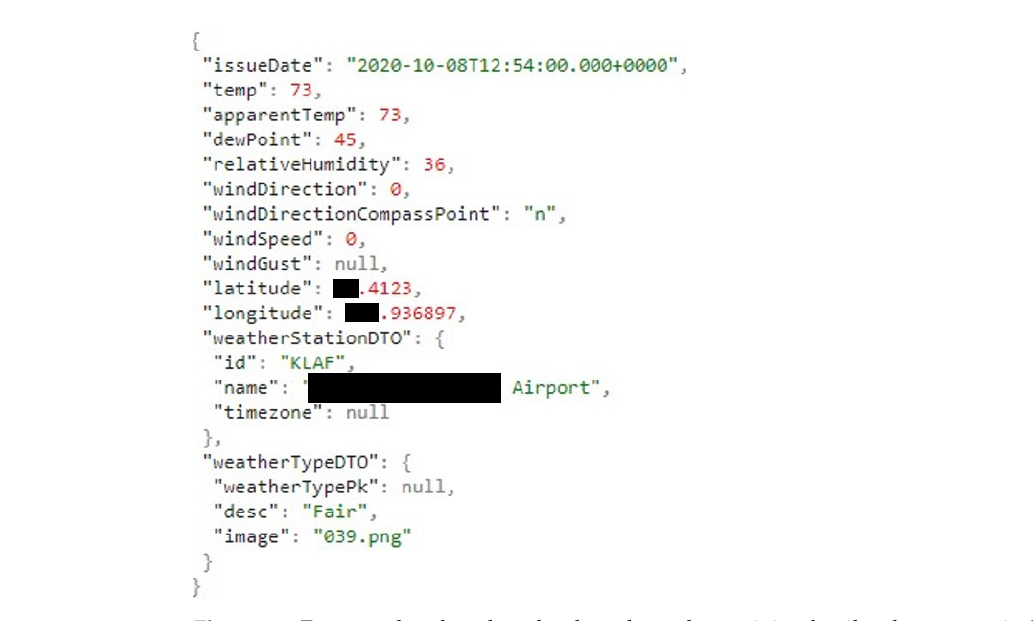
Figure 19. Formatted, reduced, and redacted weather activity details where name is the name of the weather station being used.